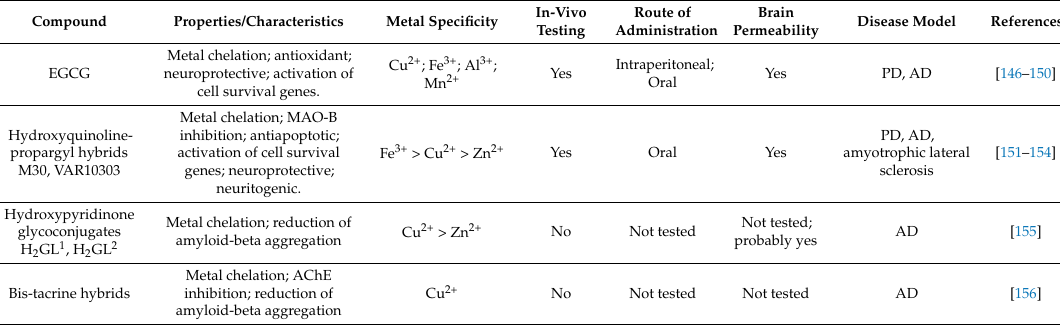
Table 1. Iron chelators with multifunctional